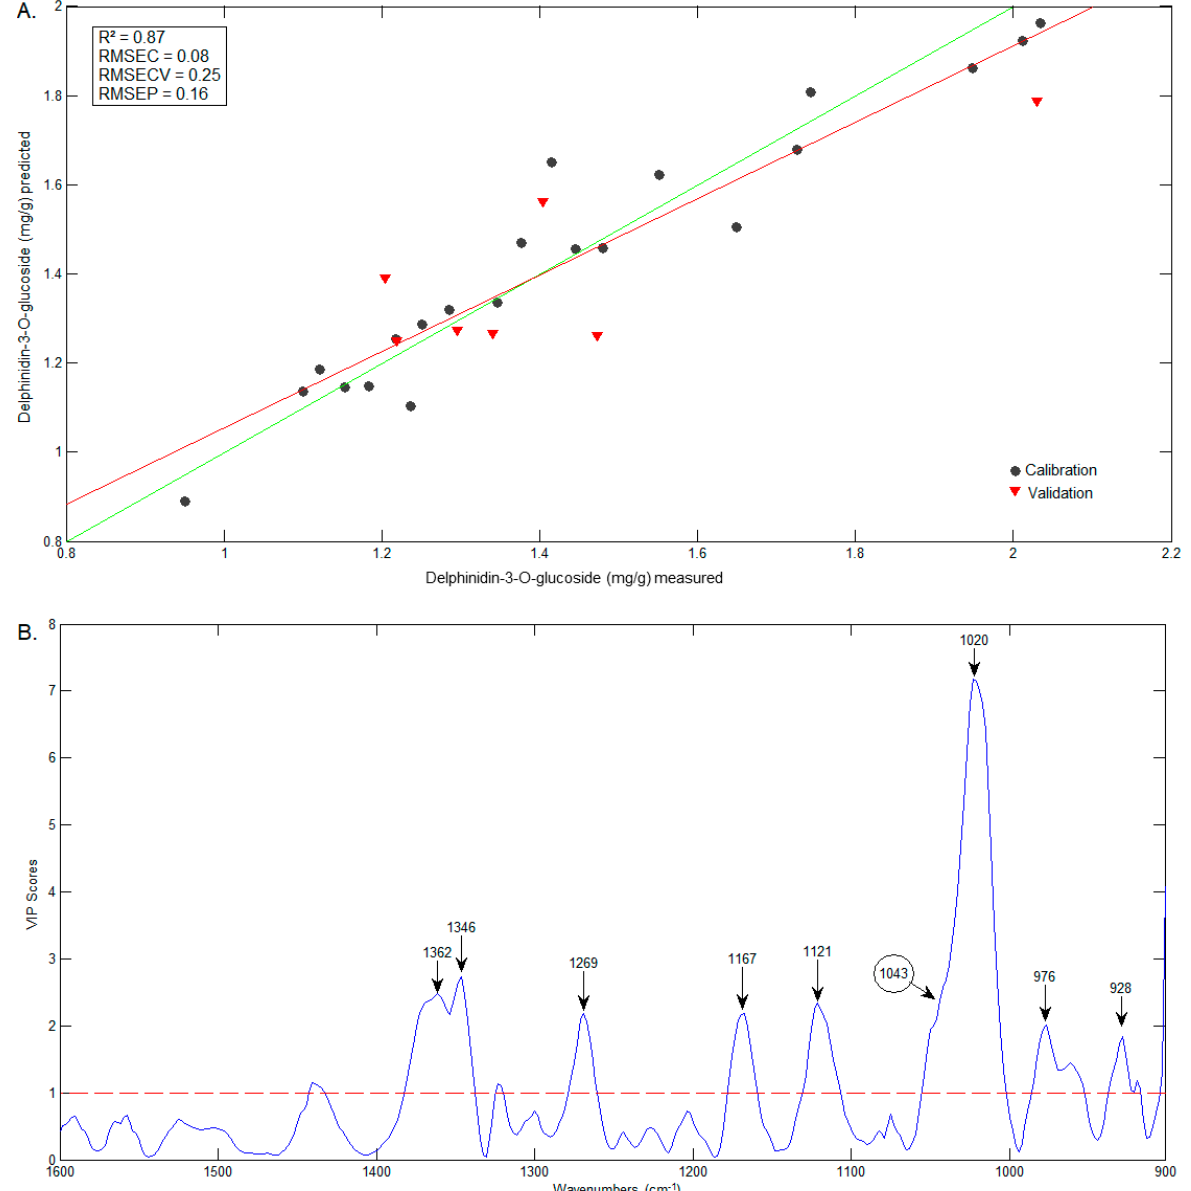
Figure 9. Graphics of the predicted vs. measured values ( A ) and of the VIP scores ( B ) of D3G.